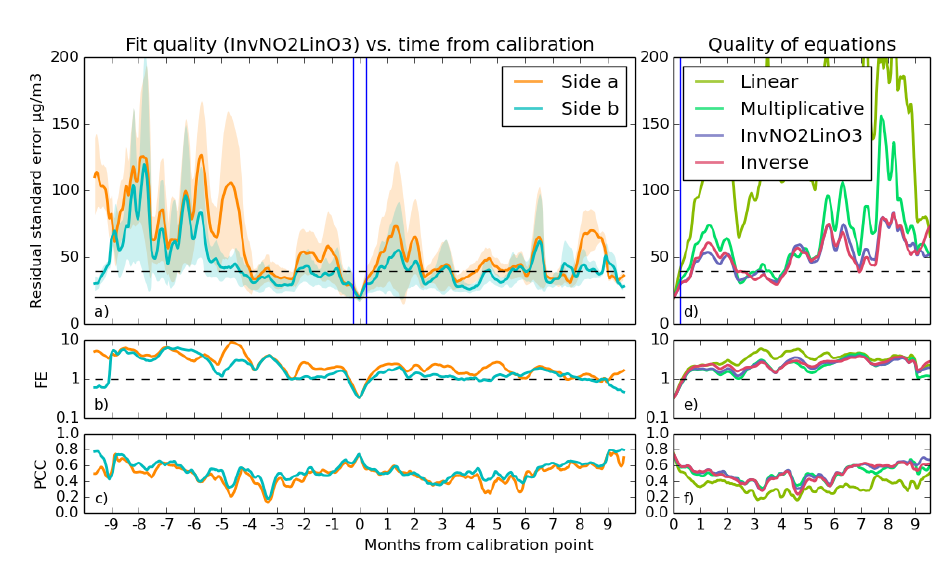
Figure 10. Long-term experiment performance for a pair of sensor elements, calibrated for NO the inverse NO linear O equation. Shown in the largest graph ( a ) is the mean rolling Residual 2 3 Standard Error (RSE) for the pair, with the shaded region showing the range within which 95% of the fits were performed. ( b ) is a graph of logarithmic Fractional Error (FE), and ( c ) shows the rolling fit Pearson Correlation Coefficient (PCC) against time From Calibration (tFC). In the right graphs is a comparison of different equations with the sensor pair results and positive and negative times averaged together. The blue line delineates the calibration period; the horizontal solid black line indicates the target accuracy of 20µgm − 3 ; and the dotted black line is twice this. On the right in graphs ( d – f ) are a comparison of the performance of the four different equations referenced in section 3.2.1. Each data point in these graphs is an average of the absolute time from calibration and of both sensors.